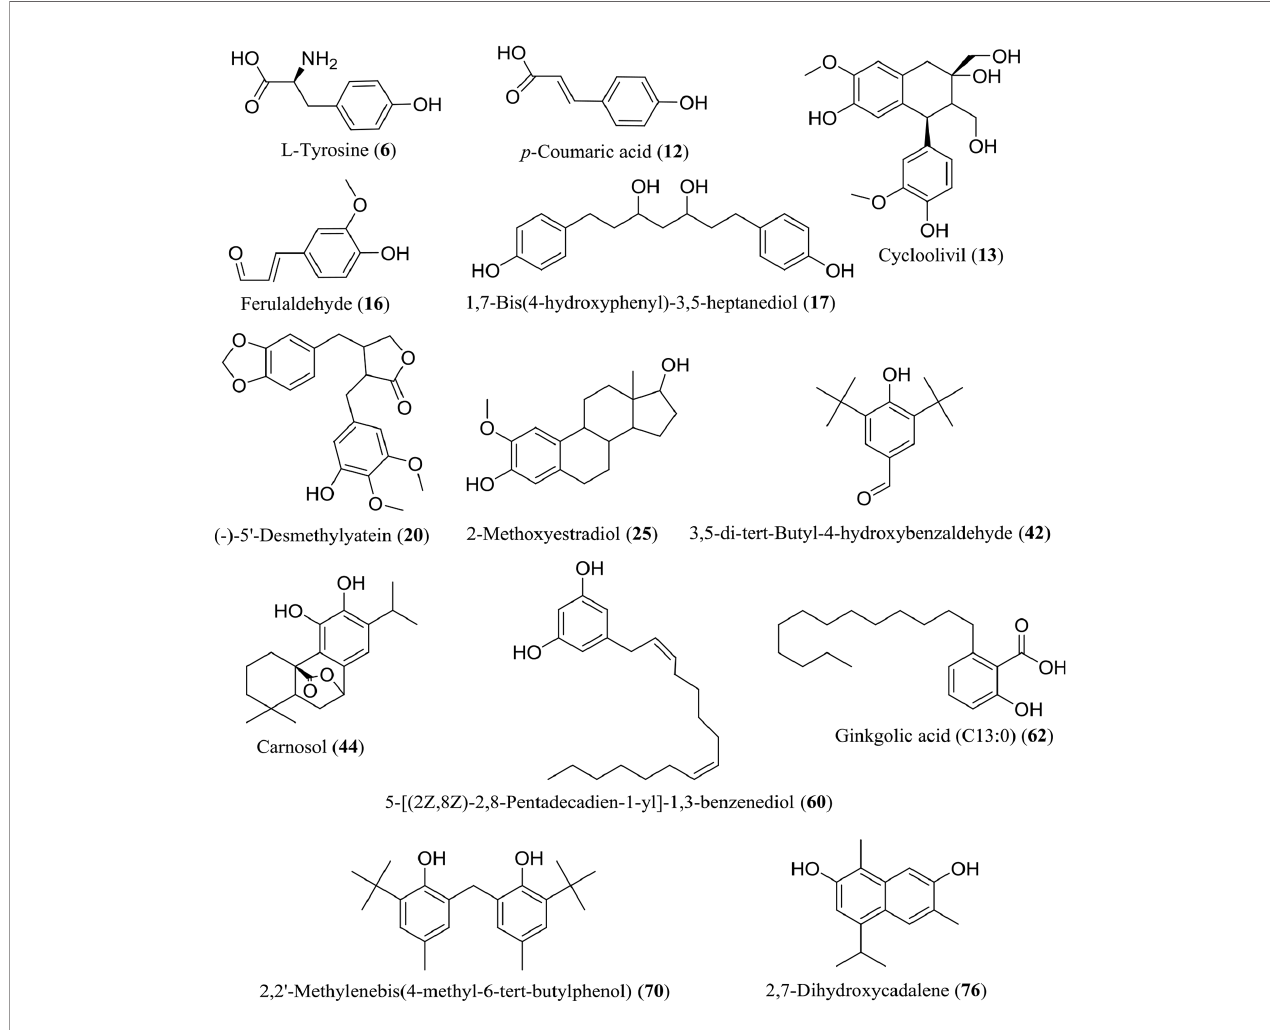
FIGURE 3 | Chemical structures of 13 identi fi ed phenolic compounds in WE and EE.